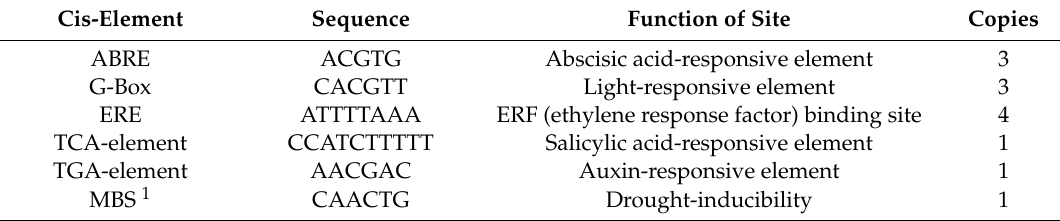
Table 3. Cis-elements were predicted in the promoter regions of AcGH3.1 related to hormone and abiotic stress in the